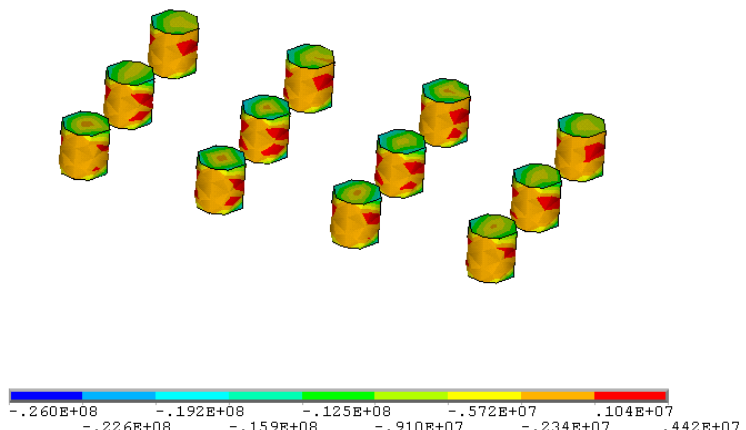
Figure 12. Maximum principal stress distribution in the ore block at 1480 mL after mining of strip pillars (parameters before optimization: stope height 3 m, pillar diameter 3 m, pillar spacing 7 m, pillar row spacing 9 m).